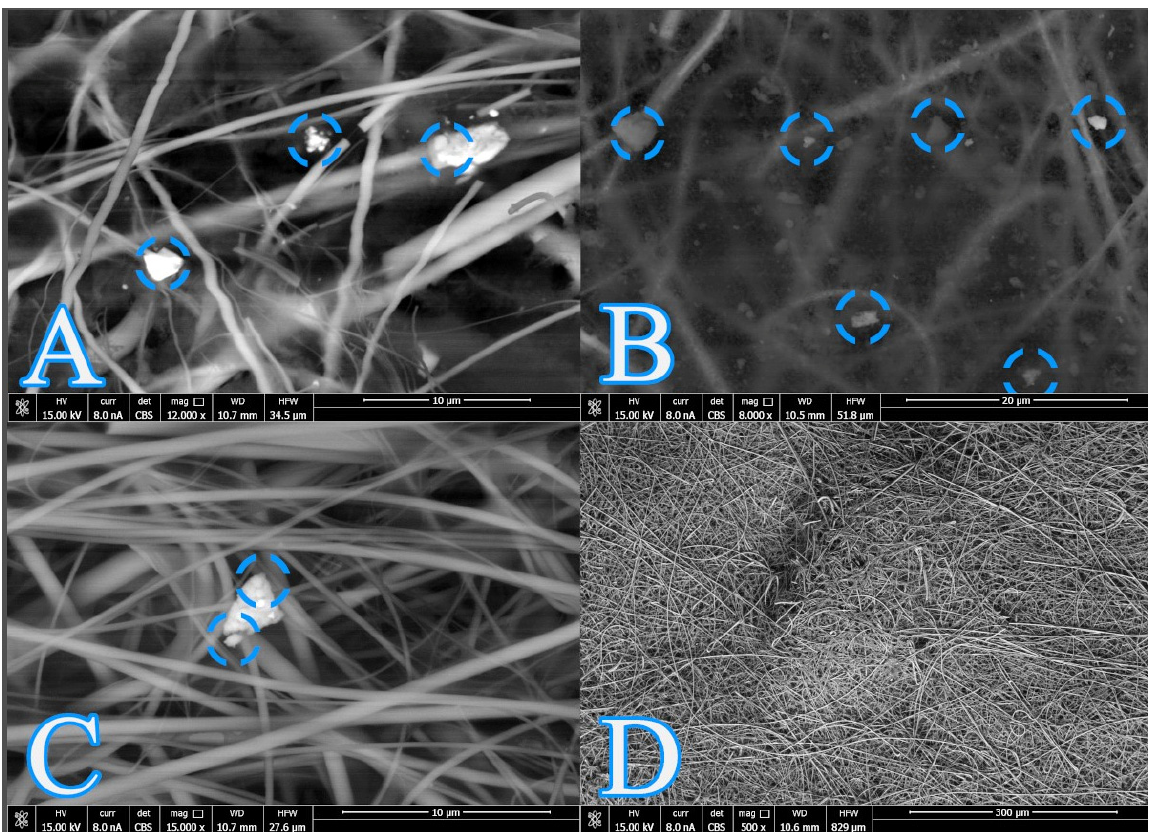
Figure 2. The SEM images of the PM samples and the blank filter. The blue circles mark the analytical points. ( A ) group A; ( B ) group B; ( C ) group D_5; ( D ) blank filter.